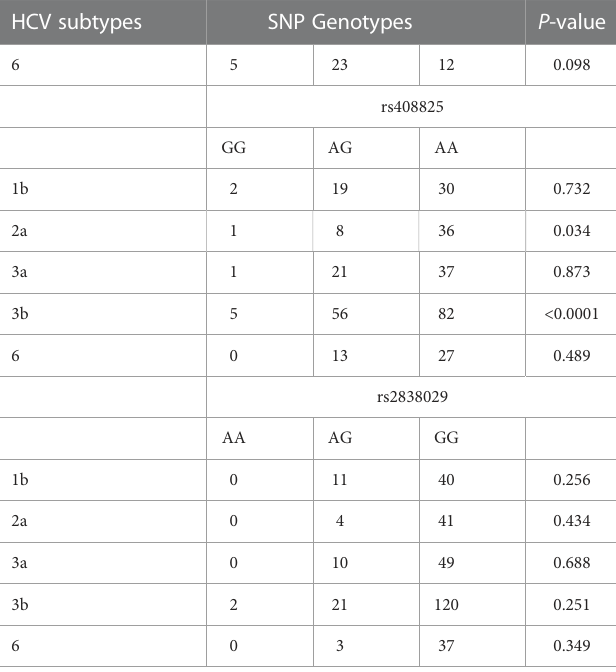
HCV subtypes were studied in 339 HCV patients with different genotypes of each